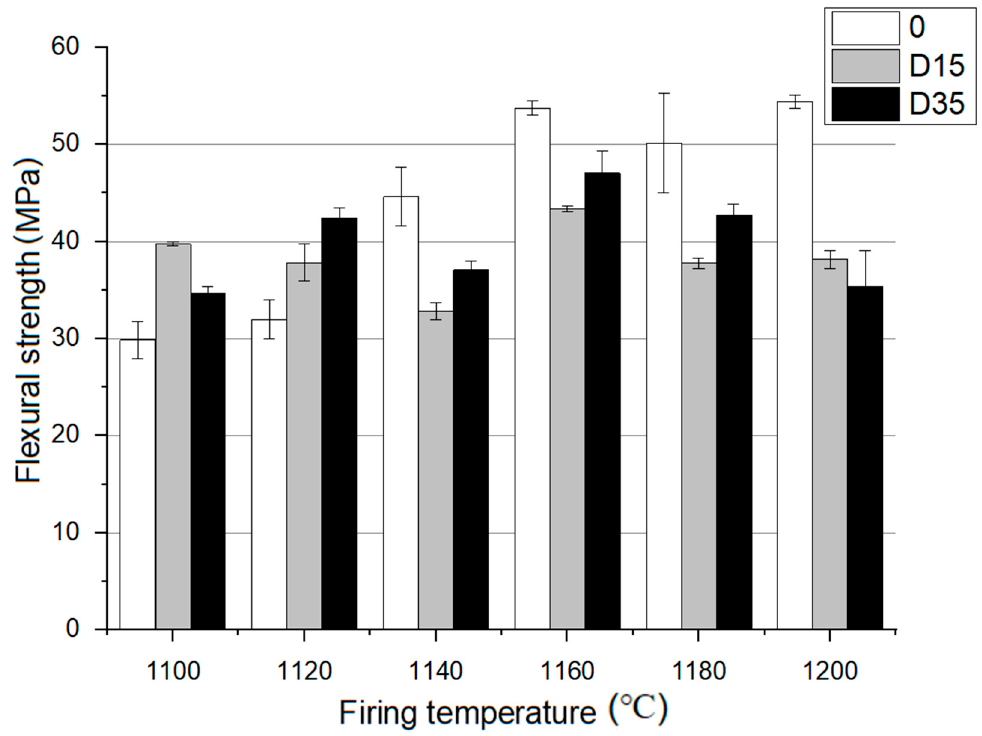
Figure 6. Flexural strength analysis for materials fired at 1100 °C to 1200 °C.